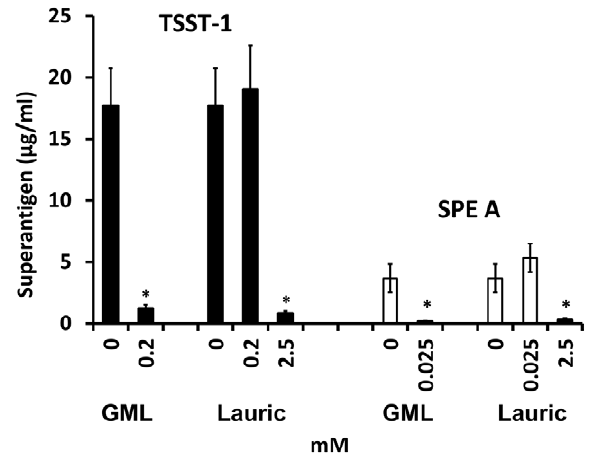
Figure 4. Comparison of GML and lauric acid for capacity to inhibit superantigen production. Staphylococcus aureus MN8 and Streptococcus pyogenes were cultured for 8 hours in the presence of GML or lauric acid. Toxic shock syndrome toxin-1 (TSST-1) production by Staphylococcus aureus MN8 and streptococcal pyrogenic exotoxin A (SPE A) production by Streptococcus pyogenes were quantified by Western immunoblot analysis. * indicates mean significantly reduced from the no GML mean at p ,